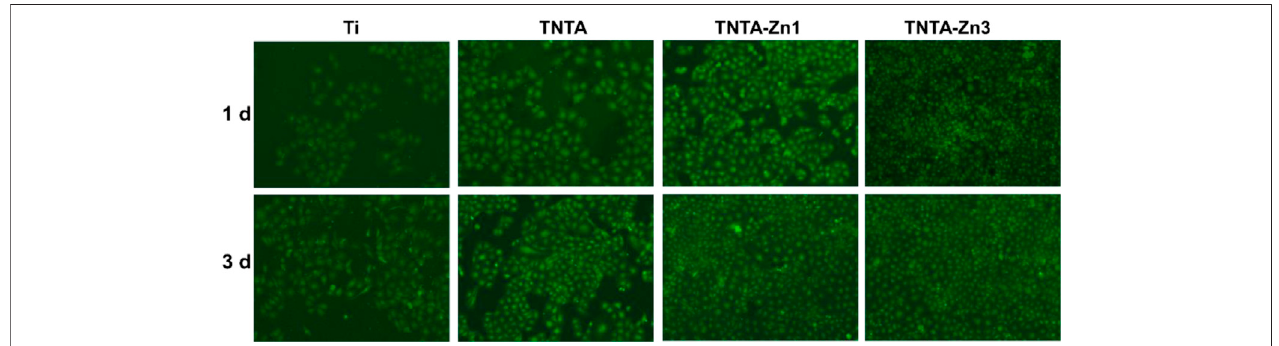
FIGURE 7 | Fluorescence images of the endothelial cells adhered on the different samples.